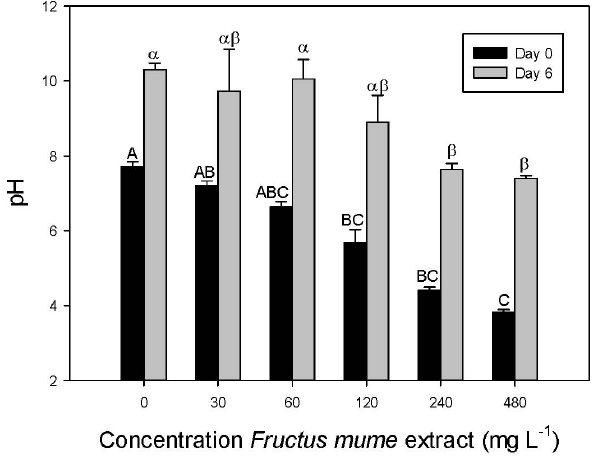
Figure 3. Effect of different concentrations filtered extracts from Fructus mume on pH of Microcystis aeruginosa NIVA-CYA 43 populations just after addition (day 0) and after six days of growth (day 6). Error bars indicate 1SD ( n = 5) and similar symbols above the bars indicate homogenous groups that are not different at the p = 0.05